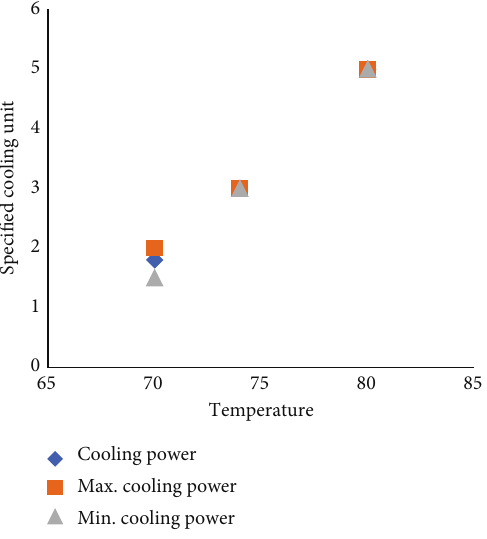
Figure 14: Various temperature cooling power uncertainty